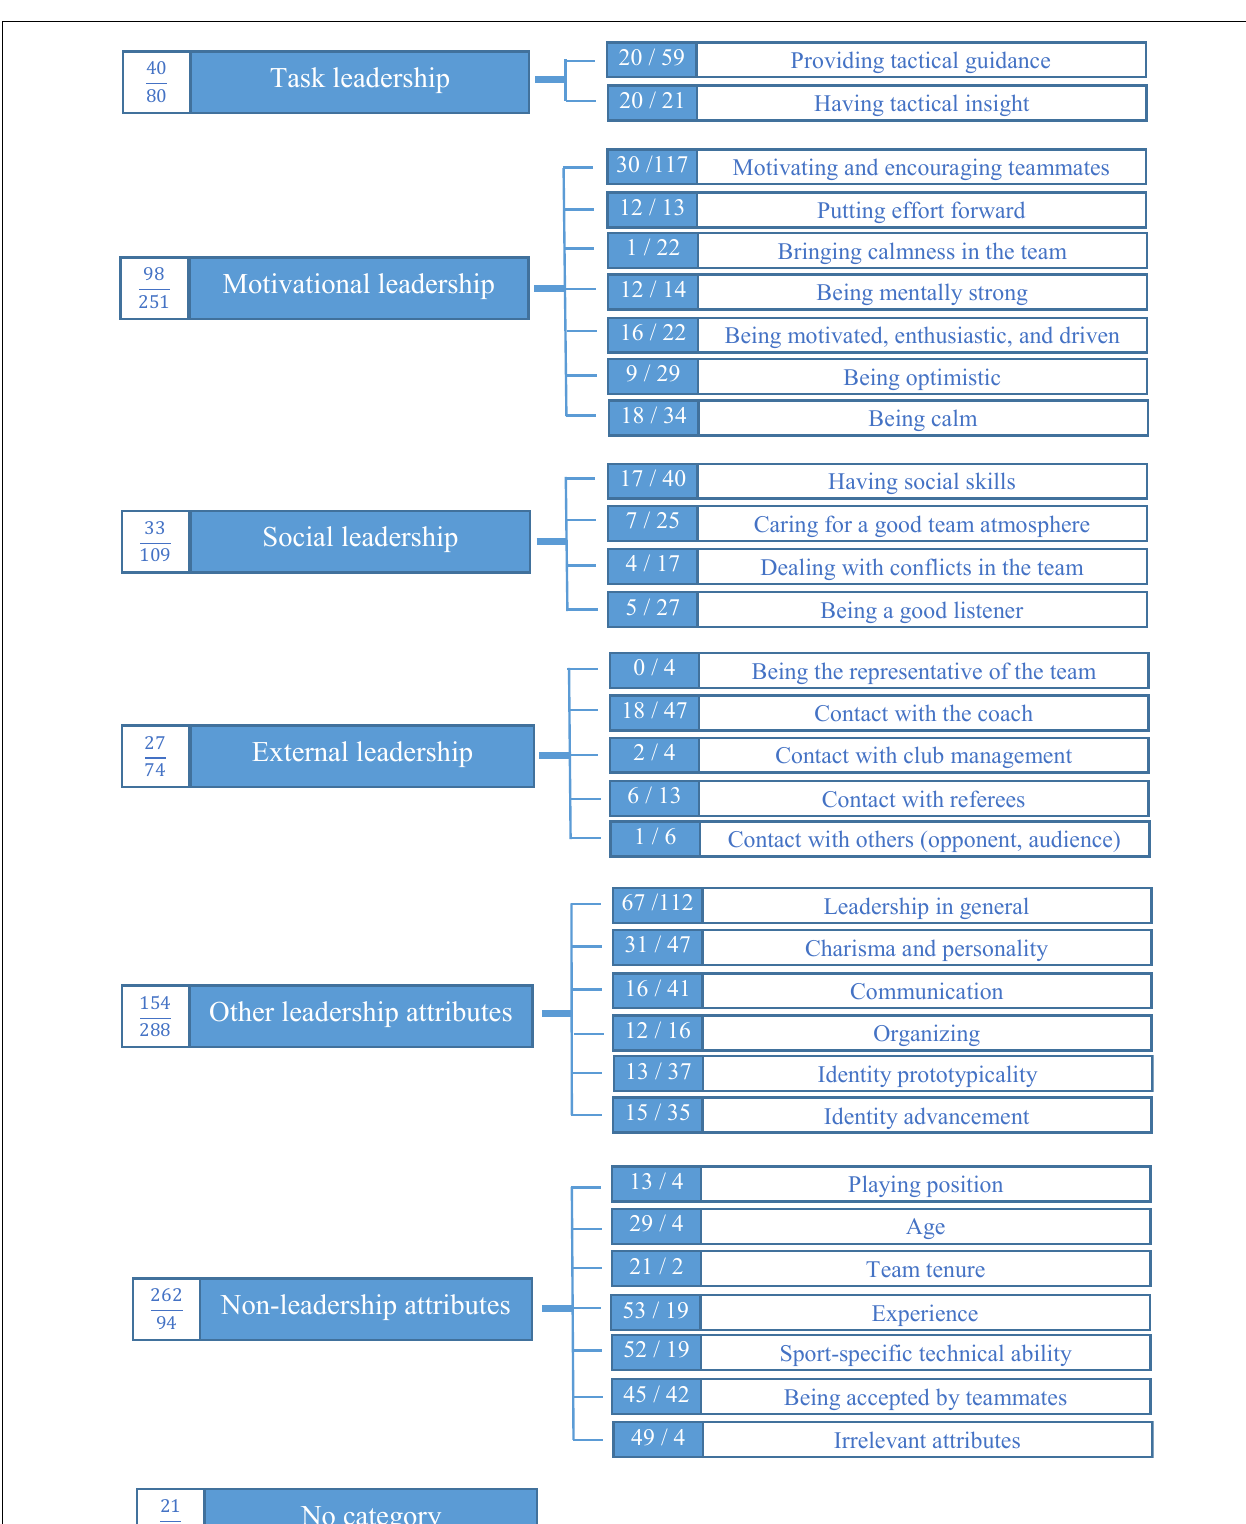
FIGURE 1 | Schematic overview of the higher-order categories (on the left) and the lower-order themes (on the right). The frequencies are presented as “number of citations of current captain/number of citations for ideal captain.